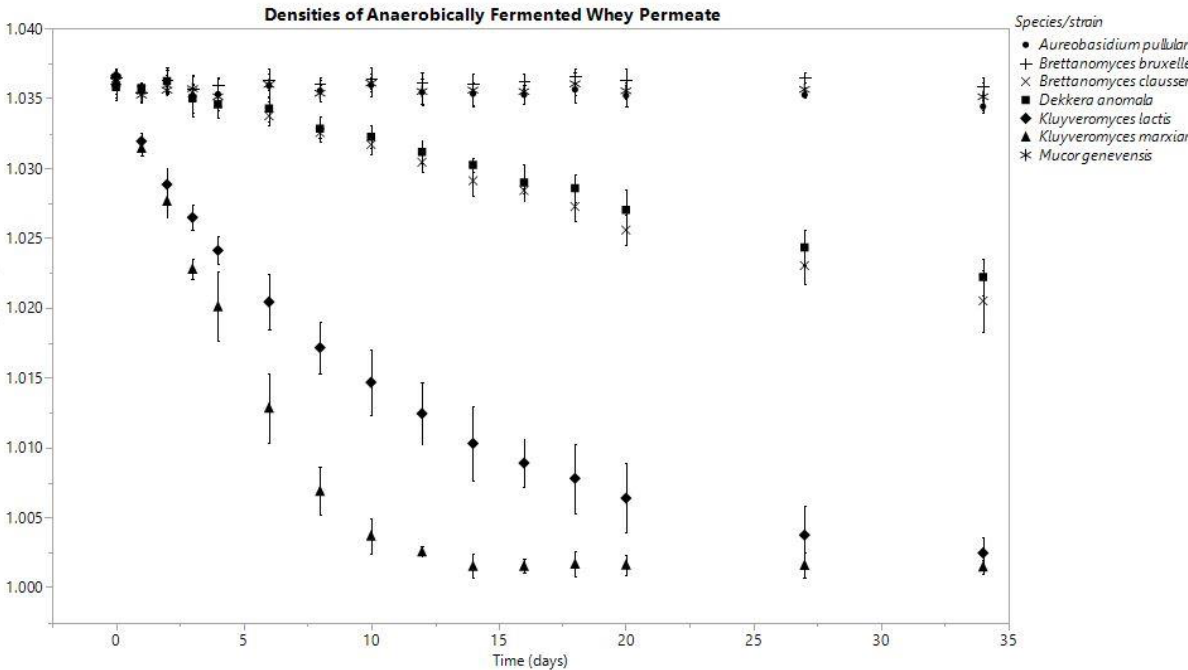
Figure 1. Means are represented by data points and standard deviation by error bars, which were calculated from three replicates for each species, except for M. genevensis , which had two viable replicates.